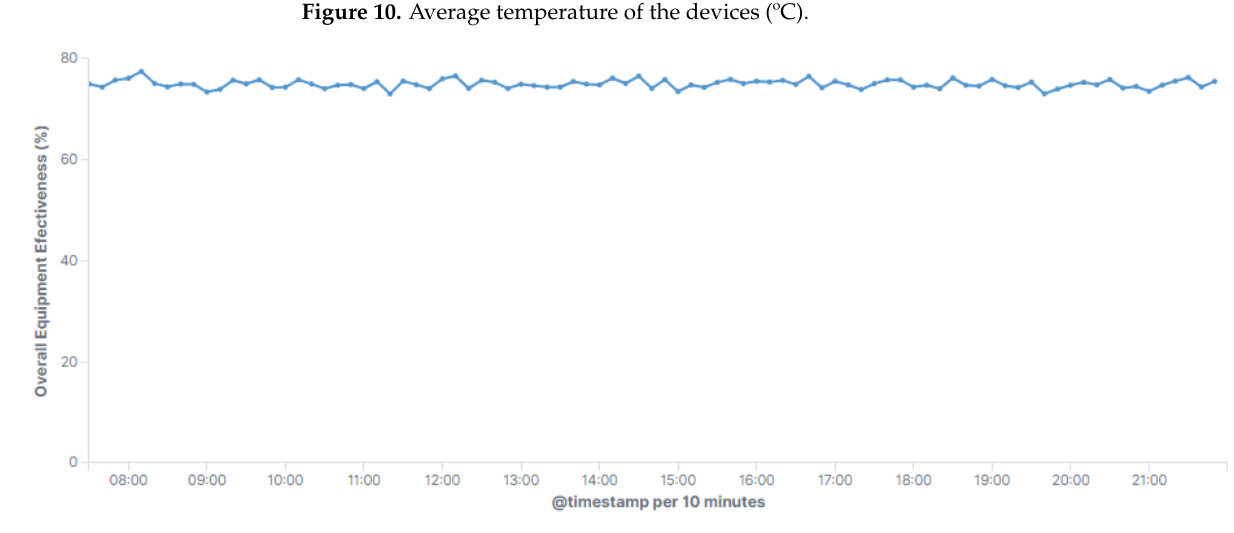
Figure 10. Average temperature of the devices (ºC).